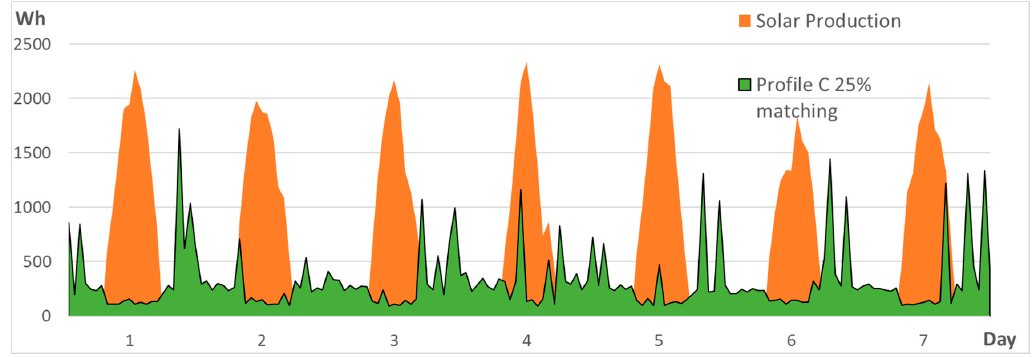
Figure 9. Electricity consumption profiles of the single prosumer used in the simulation, for a week in autumn, and comparison with their energy generation. Source: self-elaboration.